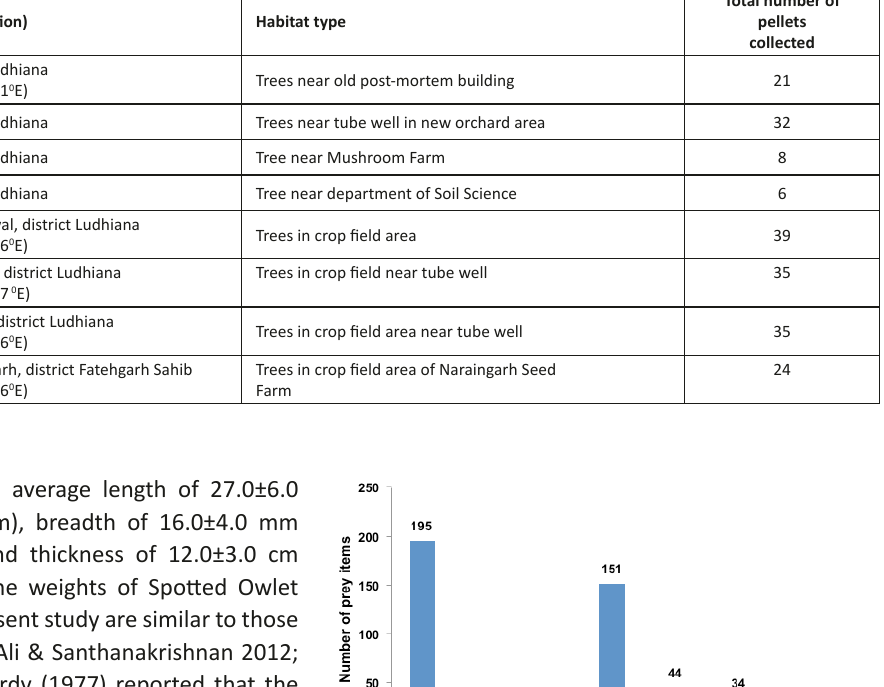
Table 1. Different locations selected for study and the number of pellets collected Location